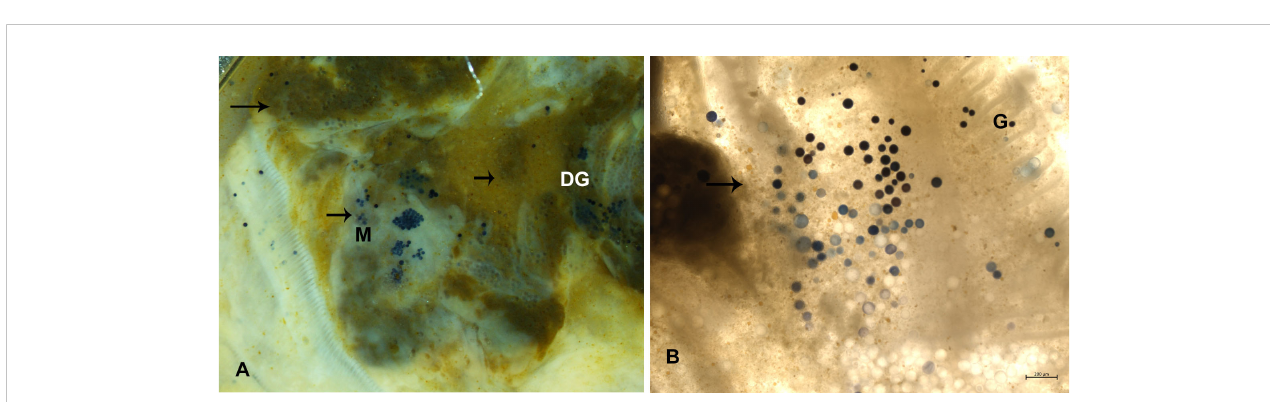
FIGURE 3 Ray ’ s fl uid thioglycolate medium (RFTM) assay. (A) Perkinsus hypnospores in very heavy infection in M. galloprovincialis in Campania in digestive tissue (DG), muscle (M) and mantle (A) and connective tissue close to the gills (G) (B)